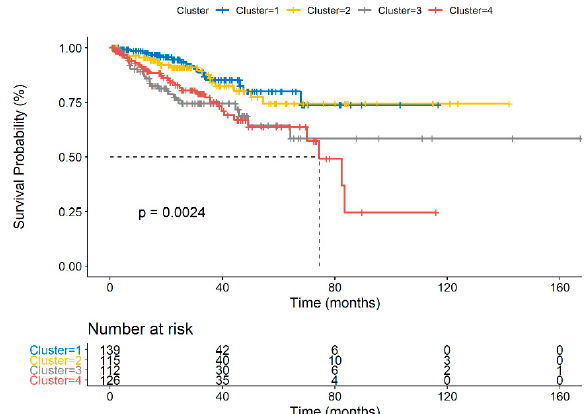
Figure 2. Figure 2 demonstrates the Kaplan–Meier curve for progression-free survival for each of the clusters in the TCGA PRAD cohort. Clusters are color coded, with a legend at the top of the figure. Number at risk at various time points is displayed at the bottom of the figure. Pairwise log-rank comparisons were conducted for each of the curves listed, and results displayed within the figure.